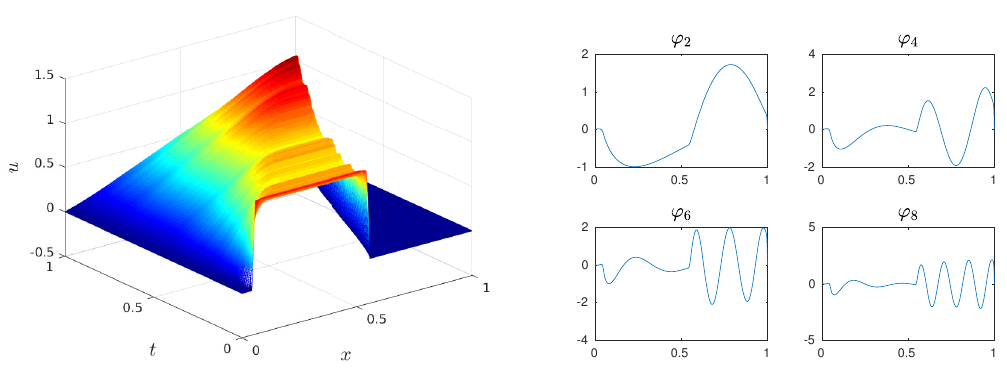
Figure 2. The numerical solution of stochastic Burgers equation (SBE) with σ = 0.3 and the proper orthogonal decomposition (POD) basis functions (left) generated from the solution